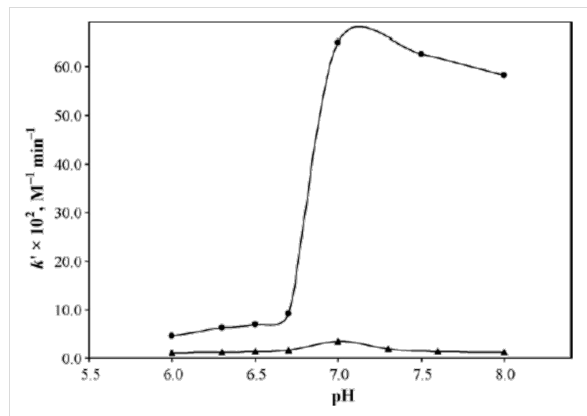
Figure 6: Plots of k ` versus pH for phosphate ( ▲ ) and sulfate ( ● ) anion-catalyzed photodegradation of RF (5 × 10 − 5 M) at 25 ± 1 °C using a Philips HPL N 125 W high pressure mercury vapor fluorescent lamp (emission at 405 and 435 nm, intensity 1.15 ± 0.10 × 10 17 quanta s − 1 ). Reproduced with permission from [30]. Copyright 2010 Elsevier.